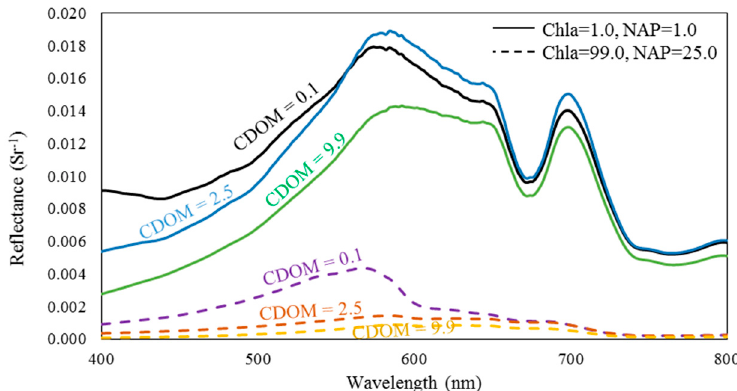
Figure 7. Comparing the influence of changing colored dissolved organic matter (CDOM) concentrations on the simulated reflectance spectra within the blue-green and red-NIR regions. The CDOM concentrations were 0.1, 2.5 and 9.9 m − 1 . The solid lines indicate chlorophyll- a (Chla) and non-algal particles (NAP) concentrations of 1.0 mg · m − 3 and 1.0 g · m − 3 , respectively. The dashed lines indicate a Chla of 99 mg · m − 3 and NAP of 25 g · m − 3 .